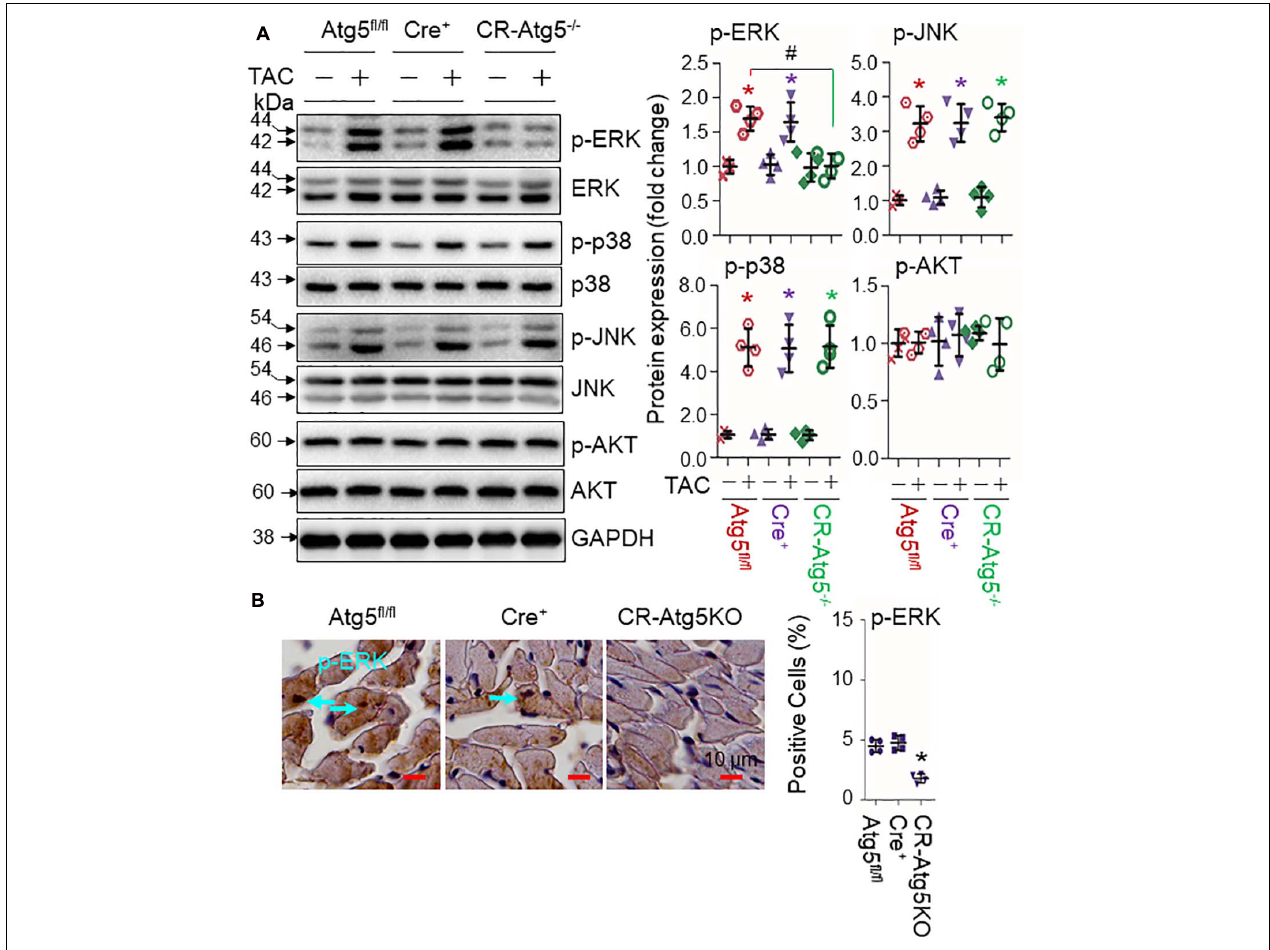
FIGURE 3 | The impact of cardiomyocyte-restricted knockout of Atg5 on pressure overload-induced activation of MAPK and expression of angiotensinogen (Agt) in the heart. Male floxed Atg5 (Atg5 fl / fl ), MerCreMer + (Cre + ), and MerCreMer + ::Atg5 fl / fl (CR-Atg5 − / − or CR-Atg5KO) after tamoxifen-induced ablation of Atg5 were subject to sham or TAC operations for 4 weeks. (A) Western blot analysis of LV tissues ( n = 4). The right panel is the semi-quantified densitometry analyses. * p < 0.05 vs TAC (–) in the same groups using the Student t test; # p < 0.05 between the indicated groups using one-way ANOVA followed by Bonferroni test. (B) Immunohistochemical staining of phosphorylated ERK and Nrf2 in pressure overloaded hearts of Atg5 fl / fl , MerCreMer + (Cre + ) and CR-Atg5KO mice. LV tissue sections of mice with indicated genotypes were stained with antibodies for phosphorylated ERK (p-ERK) and Nrf2 (data not